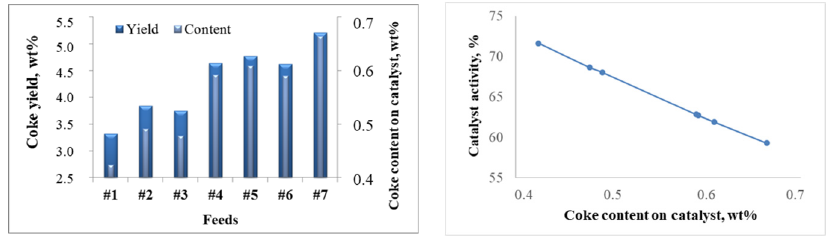
Figure 8. Feedstock-induced changes in coke yield, its content on the catalyst and relative catalyst activity.